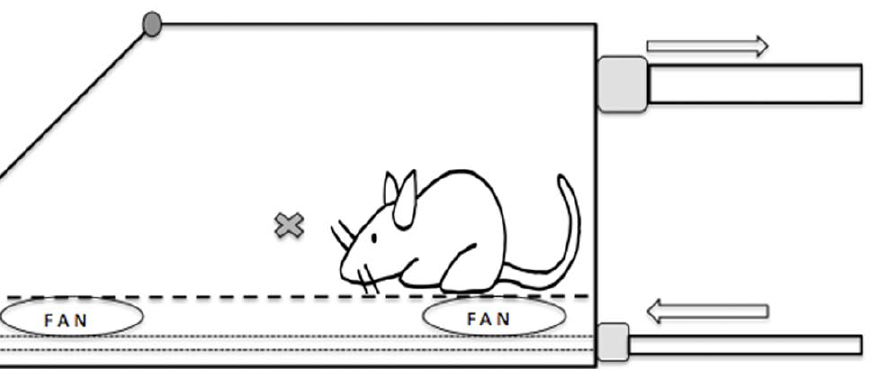
Figure 2. Diagram representing the induction chamber. The fresh gas inlet (bottom arrow) of the chosen mixture was delivered underneath a multi-perforated floor. A total of 4 mini fans were ensuring that the mixture was optimally blended. The sampling end of the sidestream gas monitoring ( X ) was positioned at mouse level, 8 cm above the floor. The gas outlet (upper arrow) was connected to an active scavenging system.